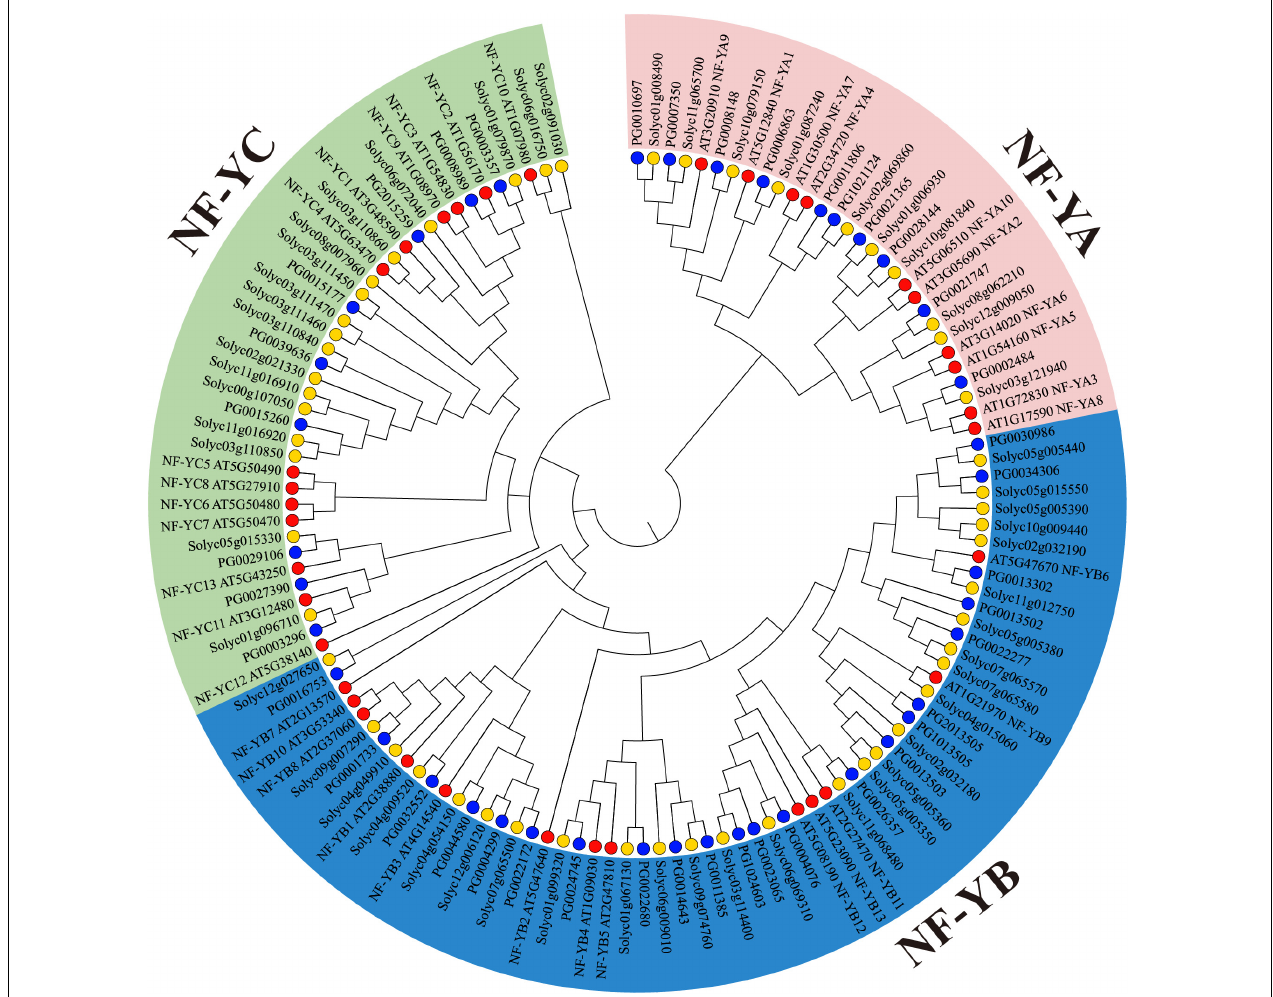
FIGURE 4 | Phylogenetic classification of NF-Ys from potato, tomato, and Arabidopsis . The three NF-Y subunits were marked with different colors. The blue circles represent StNF-Ys, the yellow circles represent SlNF-Ys, and the red circles represent AtNF-Ys.